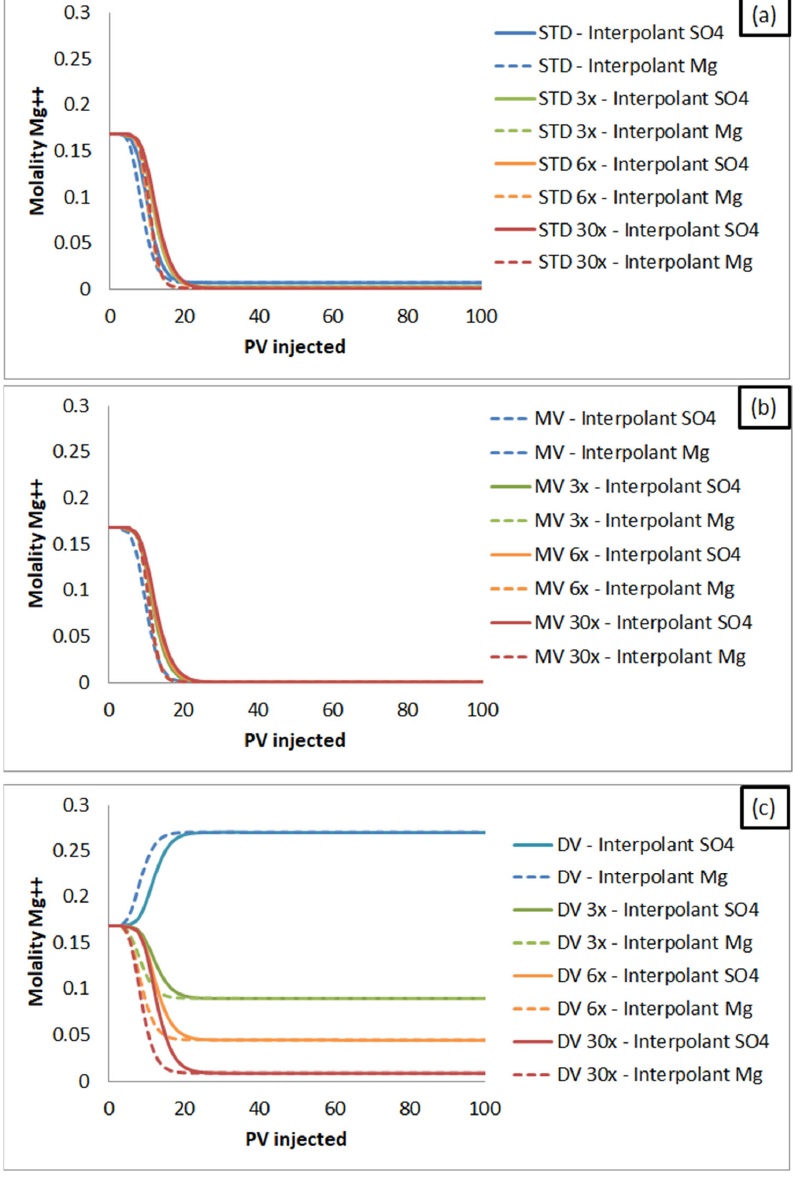
Figure 6. Mg 2+ concentration in the effluent for brine injection: ( a ) STD; ( b ) MV and ( c ) DV. SO 42 − is a component of all injected brines investigated in this work, as shown in Table 3. Therefore, the variation of this anion concentration was analyzed in the porous medium between the water ‐ wet condition (sulfate molality = 0.000008) and the oil ‐ wet condition (sulfate molality = 0.00025), as represented by point A in the Figure 2. The concentration of SO 4 2 − in the formation water (initial core condition: sulfate molality = 0.00083) is be ‐ tween these two limit values. The interpolation of the relative permeability curves was performed in this concentration range. It is possible to confirm that the curves with lower sulfate concentration, shown in Figure 5, correspond to the scenarios that showed higher oil recovery factors in Figure 4, since the value of the interpolant tends to approach the curve of the water ‐ wet state.